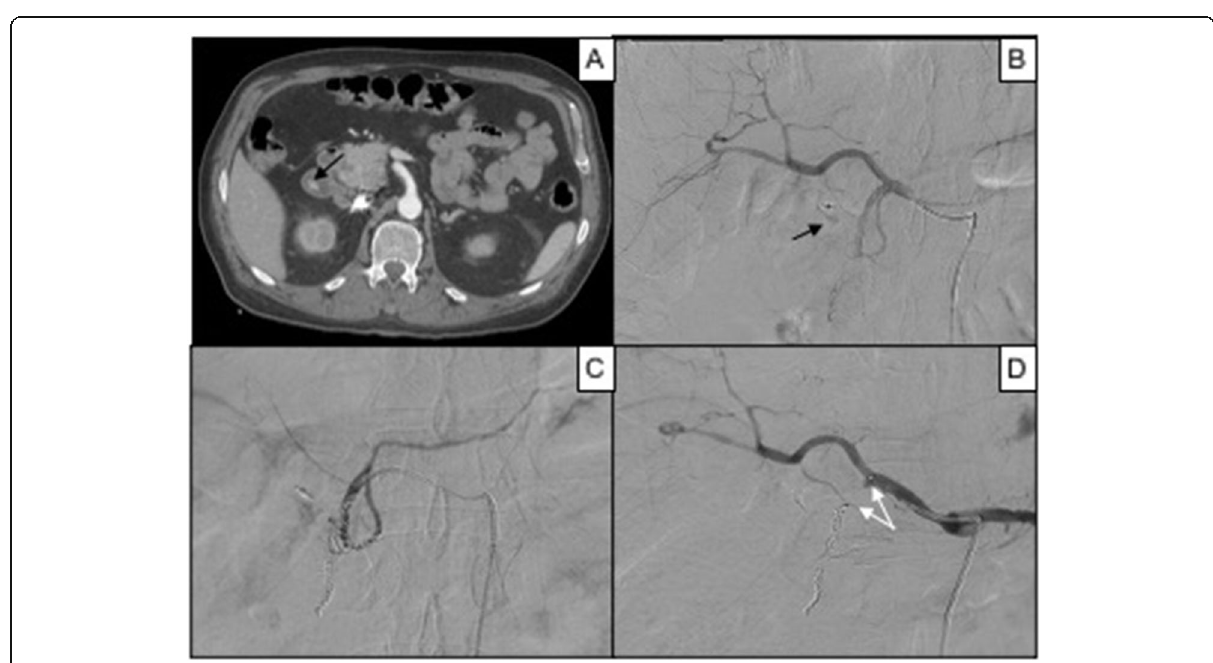
Fig. 5 67 years old male affected by bleeding duodenal ulcer; previous attempts to manage the patient endoscopically failed. In A , a contrast- enhanced CT scan in arterial phase shows active intraluminal bleeding (black arrow); in B , DSA confirms active bleeding (black arrow) from the gastroduodenal artery; in C , DSA shows uneffective coiling of the gastroduodenal artery with blood flow continuing into the vessel; in D , DSA shows complete gastroduodenal artery occlusion after release of MVP-7 (white arrows) in correspondence of the origin of the vessel (target vessel caliper 4.1